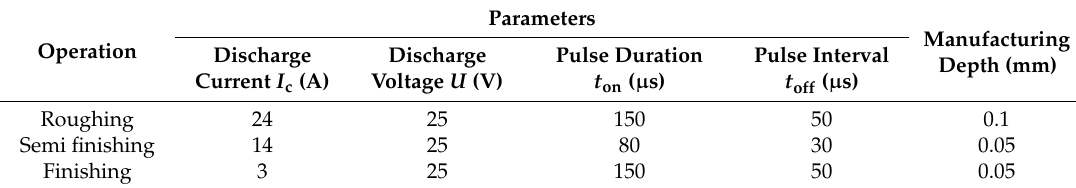
Table 6. Parameters of the EDM for sequential manufacturing.